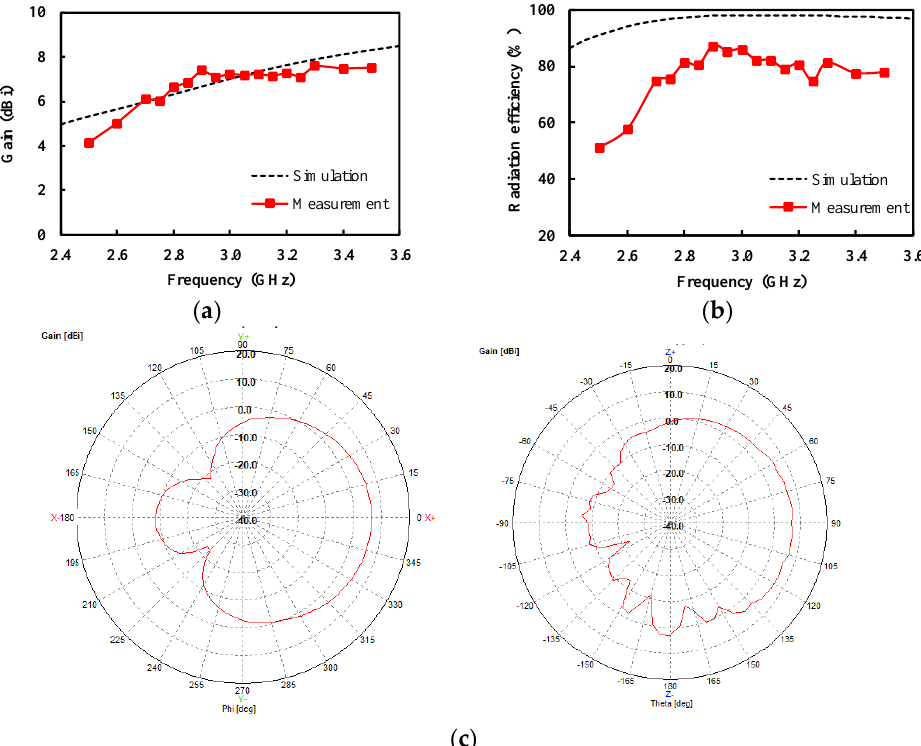
Figure 9. Measurement of the antenna in free space (with the IMDL removed) ( a ) antenna gain; ( b ) radiation efficiency; ( c ) measured radiation pattern at 3.0 GHz (left: E-plane, right: H-plane).